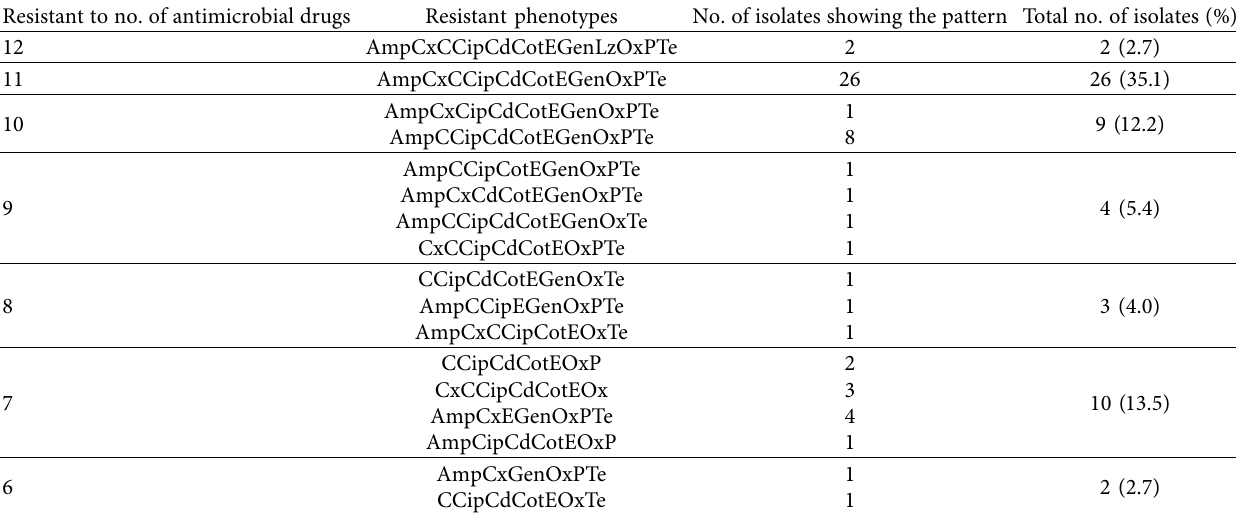
Table 3: Antimicrobial-resistant phenotypes of S. aureus isolates ( n � 74). Resistant to no. of antimicrobial